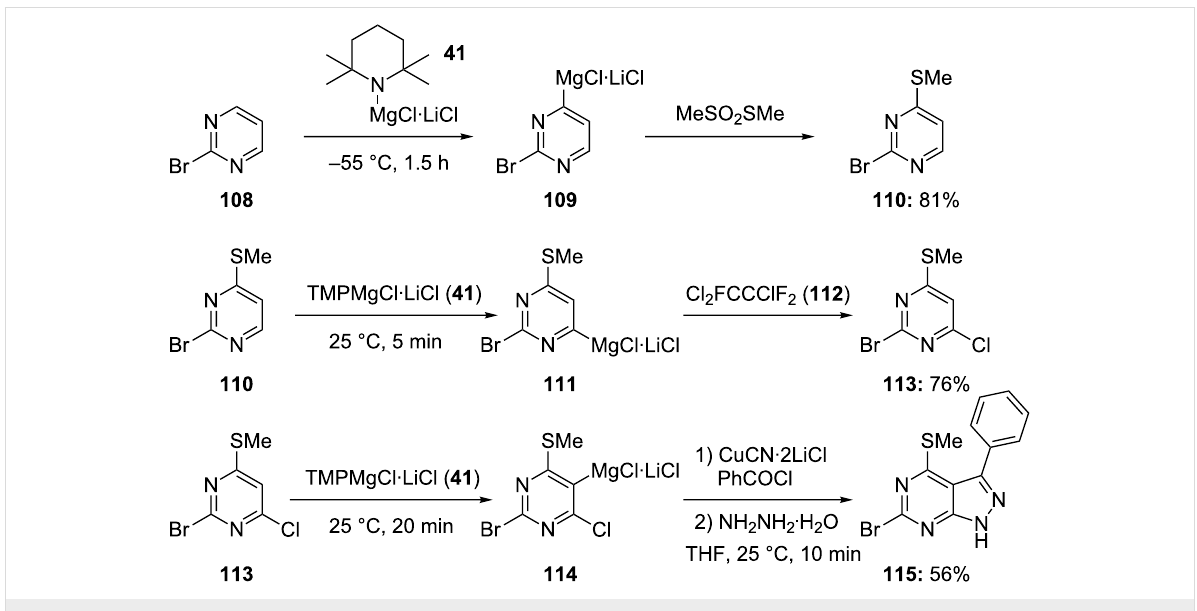
Scheme 18: Selective multiple magnesiation of the pyrimidine ring.